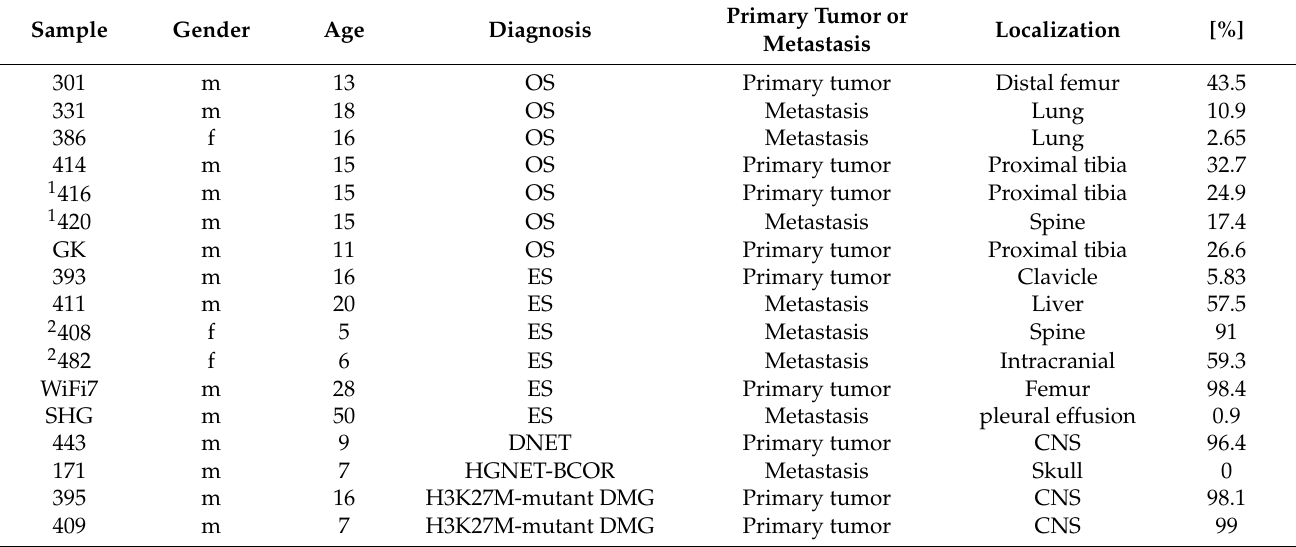
Table 1. Primary tumor cells used in the